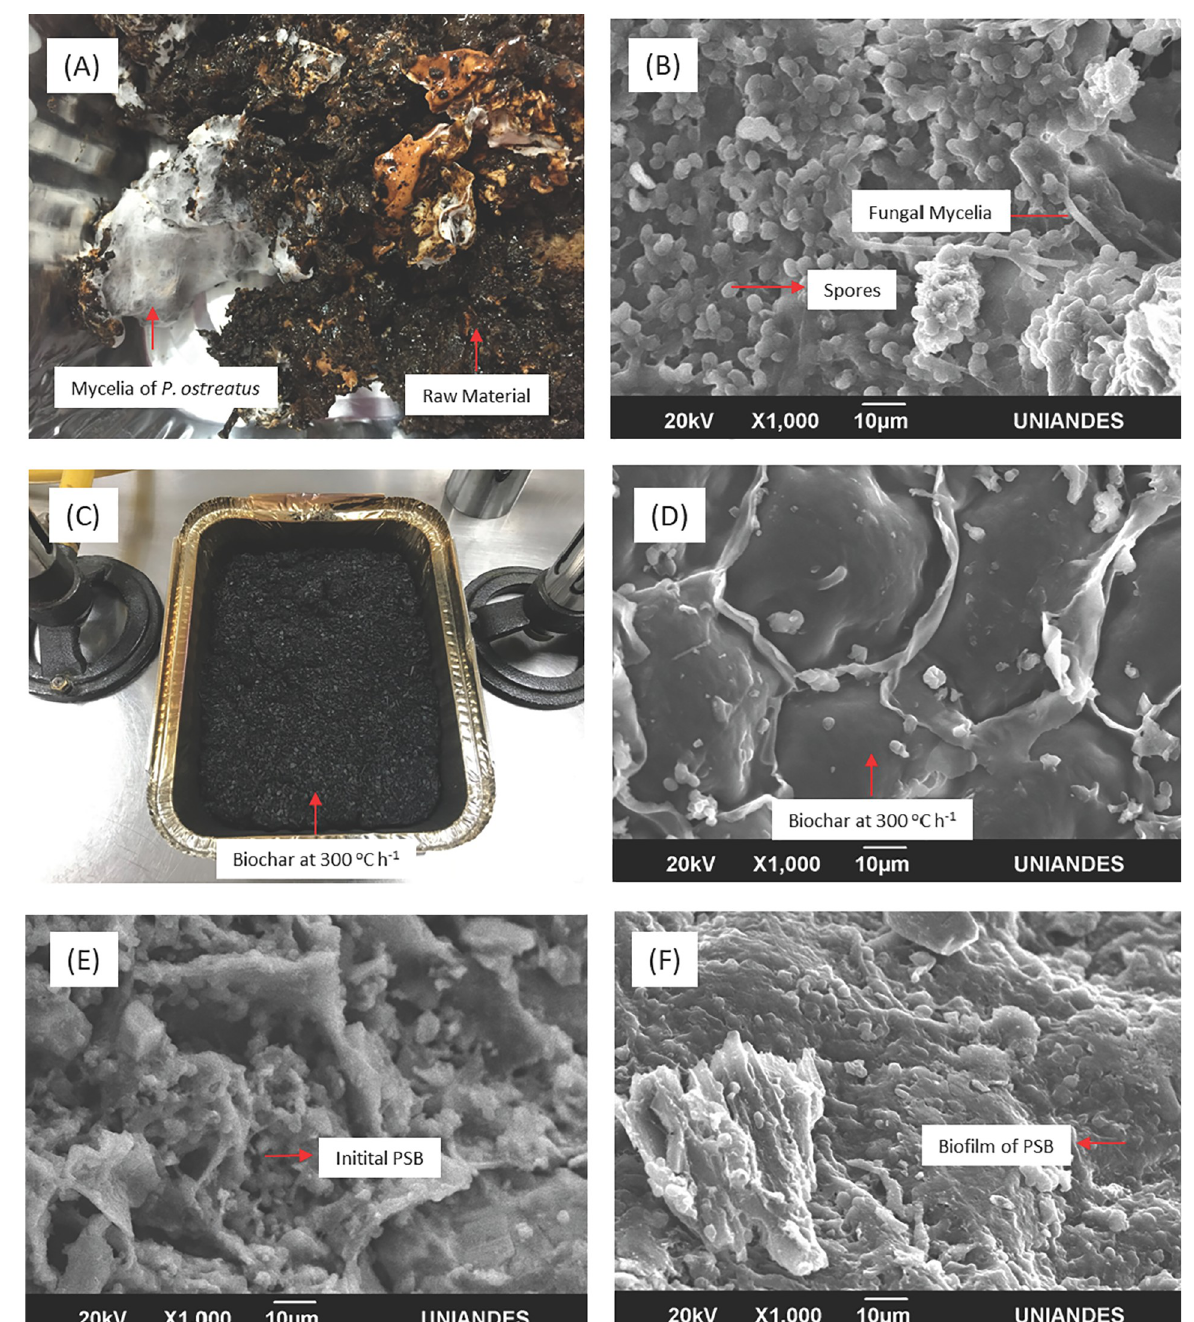
Fig 4. LCB and pretreated LDPE oxo in microcosm. (A) RM. (B) RM SEM at 1000 x. (C) BC (D) SEM of BC. (E). BC/PSB/I. (F) BC/PSB/SC. image analysis revealed P . ostreatus ’ thin hyphae and sphere-shaped spores (Fig 4B). Upon BC production a more homogenous product was obtained, of black color and thick texture (Fig 4C). Smooth surface, panel-like structures with mycelia fragments or cell debris were observed on BC/PSB/I SEM images following 300˚C treatment (Fig 4D). For BC300/PSB/SC formation